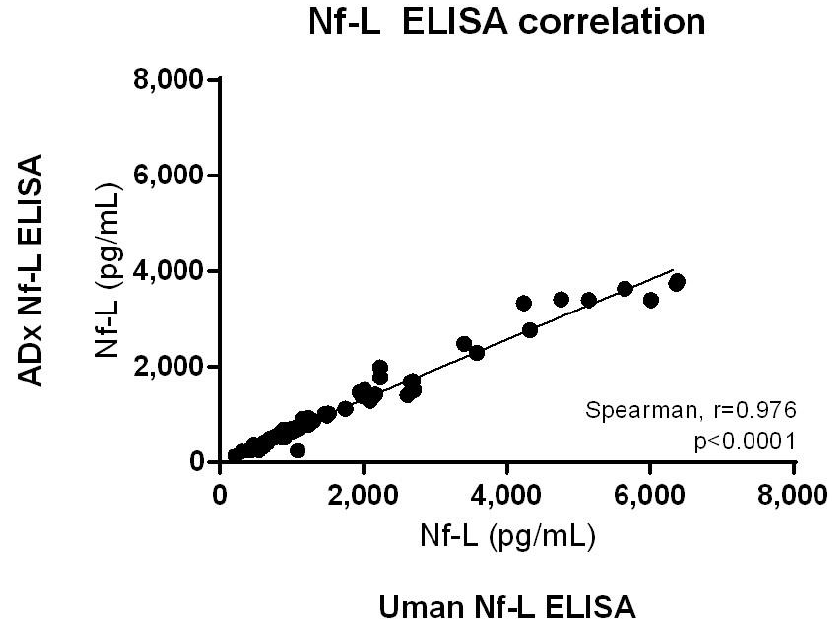
Figure 6. Correlation of 60 clinical samples measured with the ADx Nf-L ELISA and the commercial UmanDiagnostics Nf-L ELISA. The data were analyzed using the non-parametric Spearman correla- tion on GraphPad Prism v.6.07. The correlation is significant (Spearman rho = 0.976, p < 0.0001).